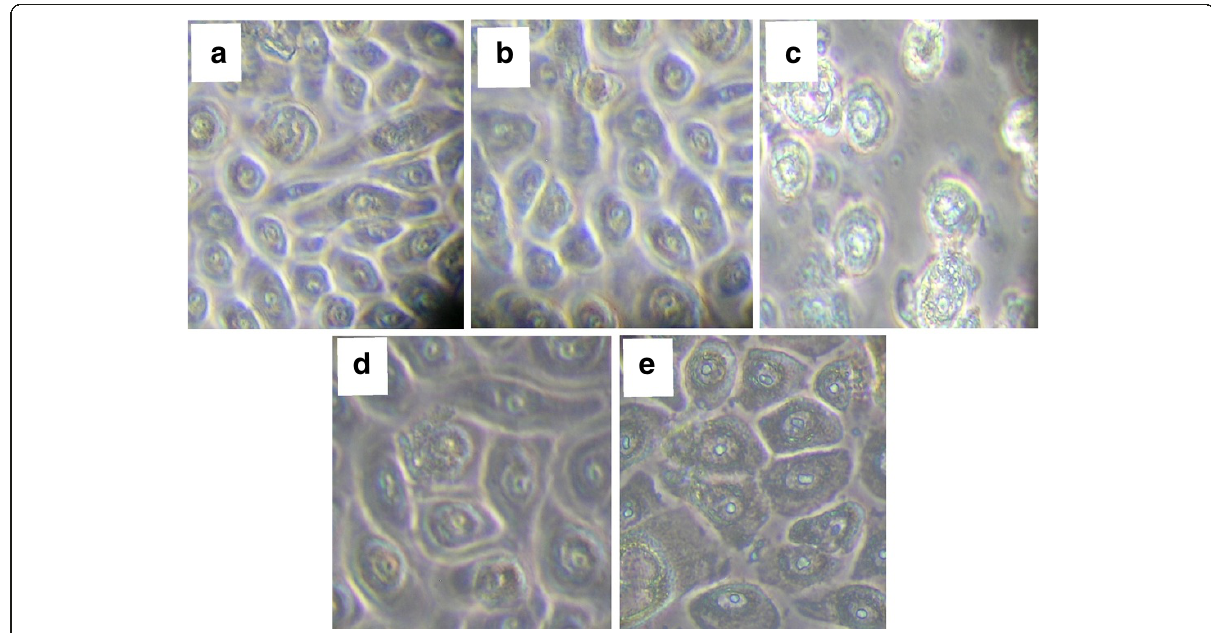
Figure 2 Effect of CPV in Homo sapiens skin keratinocyte (HEK001) ATCC CRL-2404 ™ cell monolayer. ( a ), normal HEK001 keratinocyte cell monolayer; ( b ), HEK001 keratinocyte cell monolayer treated with equal volume of DMSO used in CPV treatment; ( c ), HEK001 keratinocyte cell monolayer exhibiting cytotoxic effect caused by SDS (25 μ g/mL); ( d ), HEK001 keratinocyte cell monolayer treated with 0.1% CPV; ( e ), HEK001 keratinocyte cell monolayer treated with 0.2% CPV. Magnification ,